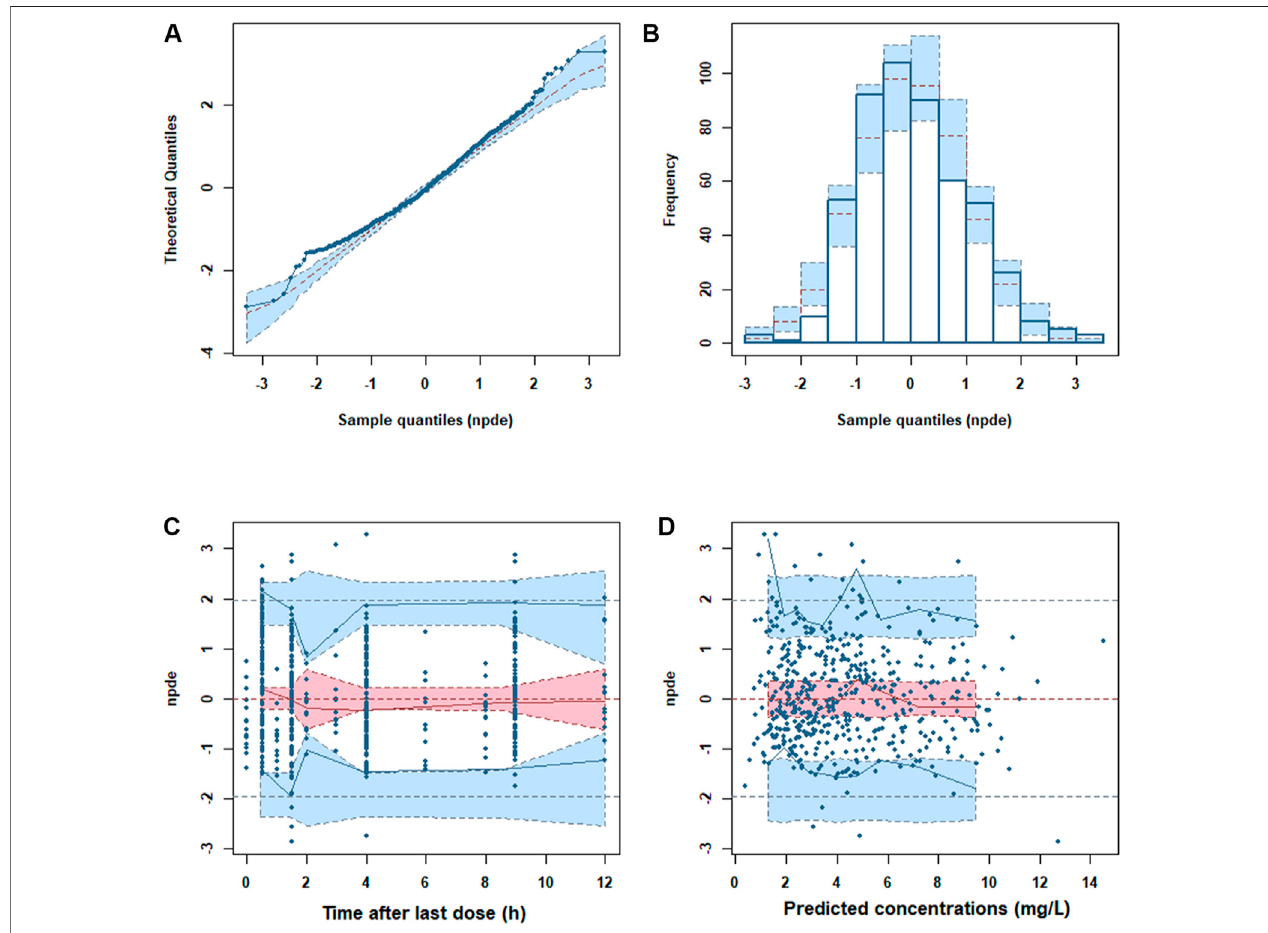
FIGURE3| Normalizedpredictiondistributionerror(NPDE)metricsofthe fi nalmodel. (A) QQplotoftheNPDE. (B) DistributionoftheNPDE. (C) NPDEversustime. (D) NPDE versus predicted concentrations.